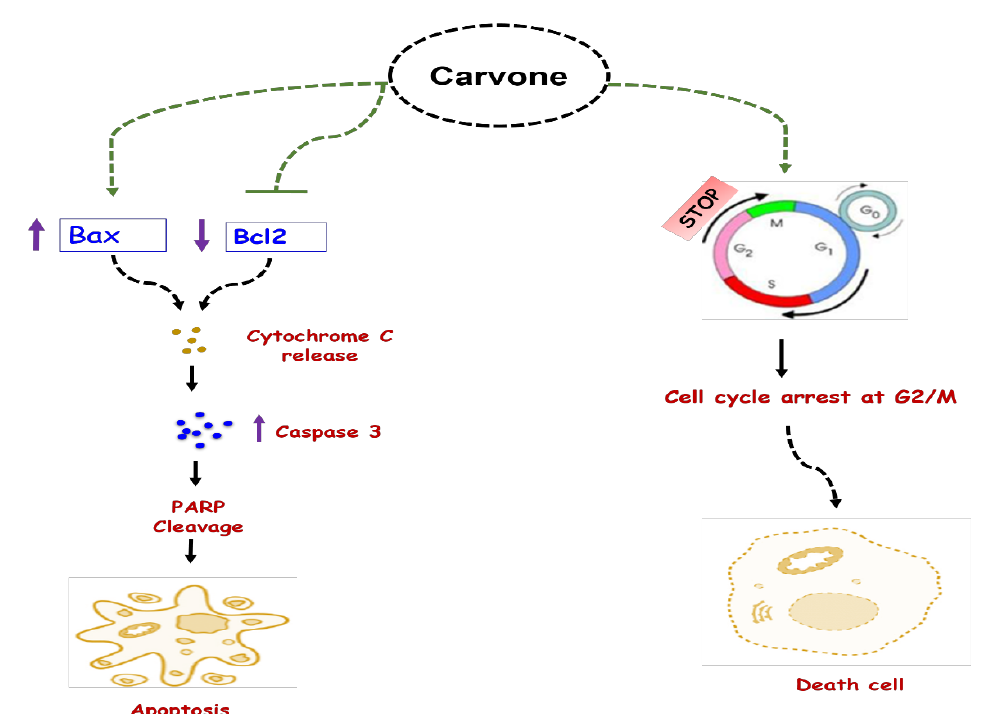
Figure 3. Anticancer mechanisms of carvone. Carvone can induce anticancer effects by two main mechanisms: 1) intrinsic apoptotic action via decreasing Bcl2 and decreasing Bax, as well the release of cytochrome C which induce caspases ex- pression and PARP cleavage; 2) cell cycle arrest at G2/M via its action on cyclin-dependent kinase 1.